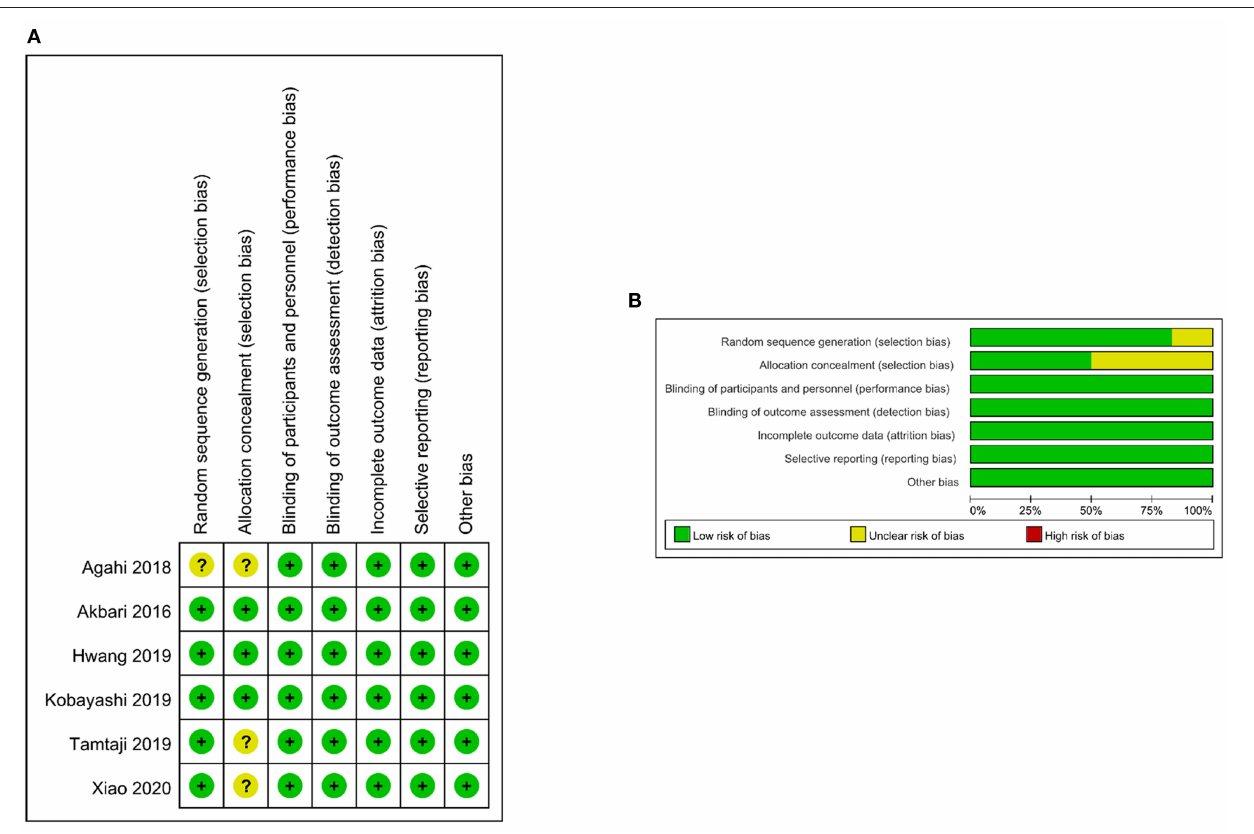
FIGURE 2 | Risk-of-bias assessment for the randomized trials included in the meta-analysis. (A) Risk-of-bias summary. (B) Risk-of-bias graph. Symbols: ( + ), low risk of bias; ( ? ), unclear risk of bias; ( − ), high risk of bias.